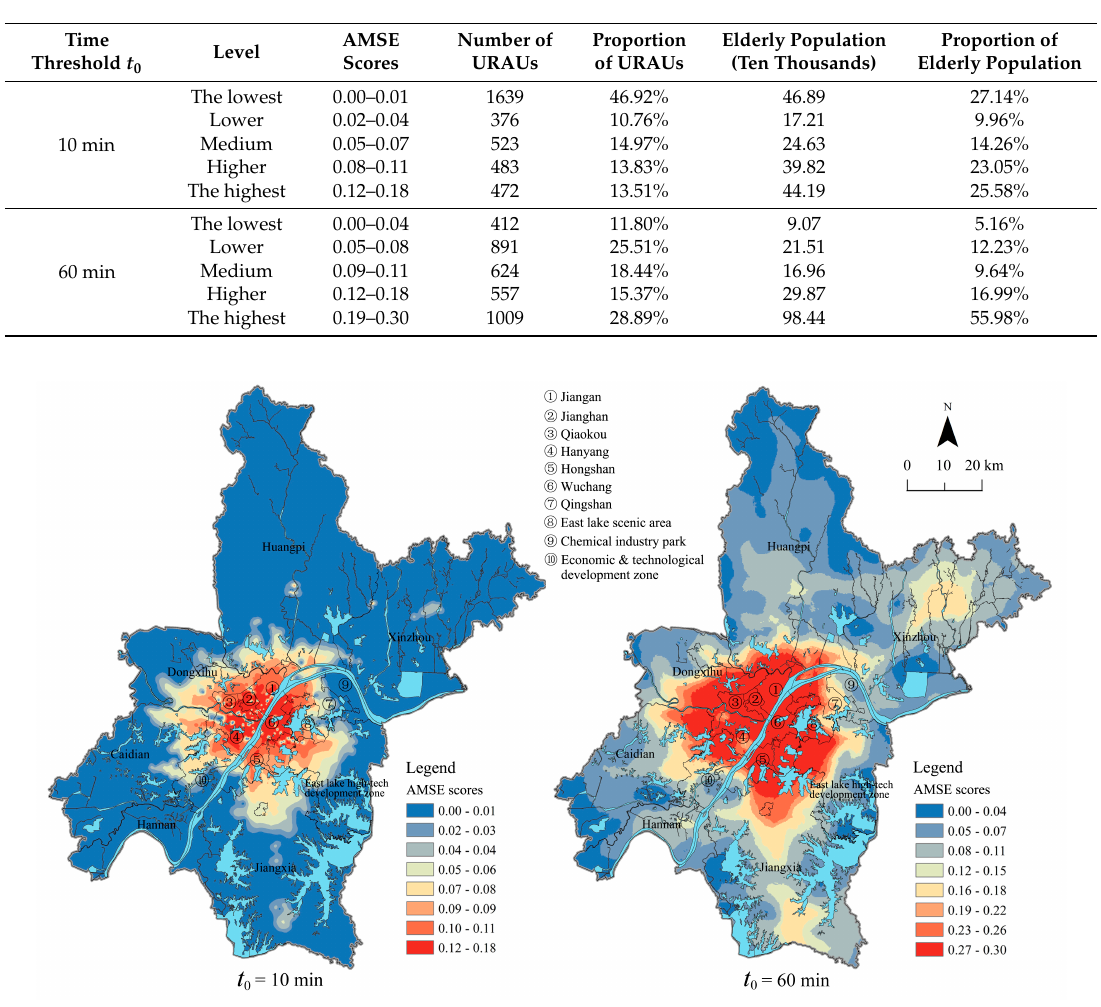
two time thresholds.